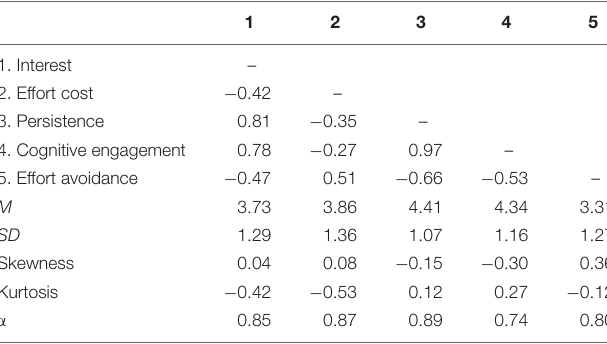
TABLE 1 | Descriptive statistics and latent